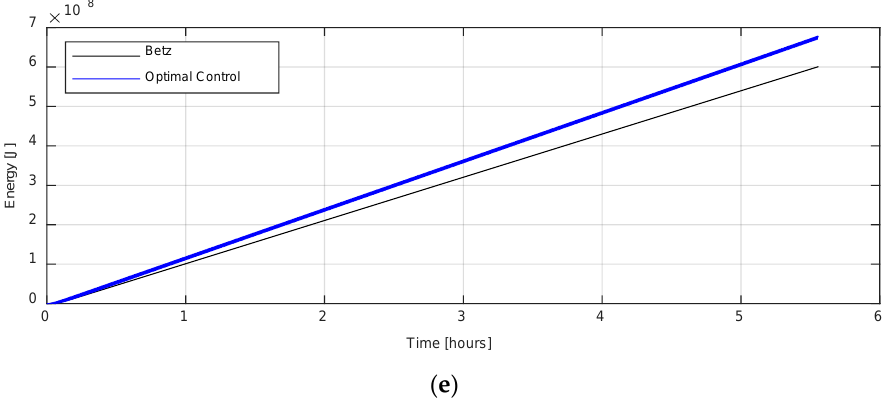
Figure 6. Comparison between the OCBM optimal control and Steady wind turbine for harmonic fluctuations: ( a ) the zoom of the wind speed fluctuation; ( b ) the wind speed Fourier transform; ( c ) the instant power, ( d ) the speed ratio; ( e ) the energy storage.